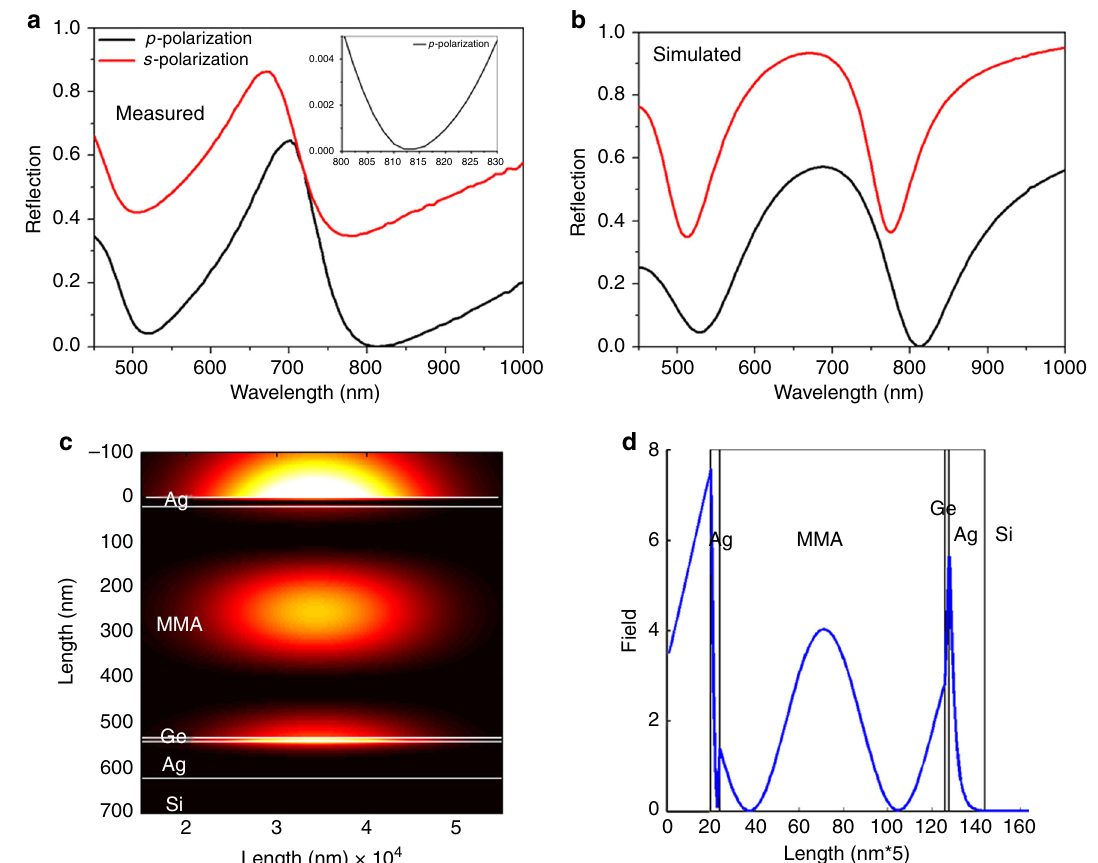
Fig. 3 Re fl ectivity spectra and fi eld distribution. a Experimental and b calculated re fl ection spectra for p - and s -polarization at a 61° angle of incidence. The obtained re fl ected intensity at 814 nm is 0.001%. c Calculated fi eld distribution along the four-layered system at the point of darkness condition (814 nm and 61°), and d its magnitude as a function of depth along the